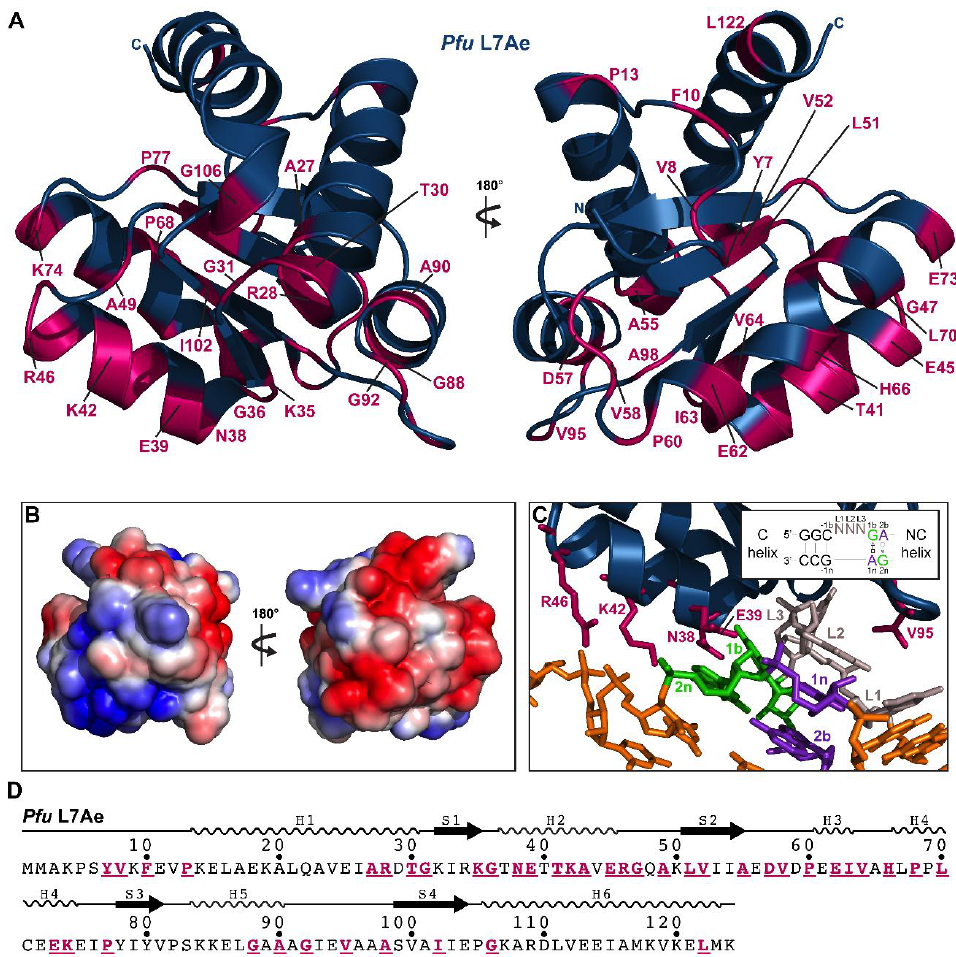
Figure 4. Highly conserved residues and RNA–protein interactions in Pfu L7Ae. ( A ) Tertiary structure of Pfu L7Ae [PDB: 3NVI [55]]. All positions with ≥80% identity from the alignment of 71 representative archaeal L7Ae sequences are highlighted; ( B ) Electrostatic potential map of the surface of Pfu L7Ae; the orientations are identical to those in panel A; ( C ) Binding interface between Pfu L7Ae and a box C/D RNA [PDB: 3NVI [55]]. Residues involved in interactions with the RNA ligand are highlighted. Inset shows a standard K-turn motif with its canonical (C) and non-canonical (NC) helices [49]; the two sheared G•A base pairs as well as the three-nucleotide bulge have been color-coded in both the inset and the main panel; ( D ) Location of conserved residues (underlined and using the same color scheme as in (A)) and secondary structure elements in the sequence of L7Ae.